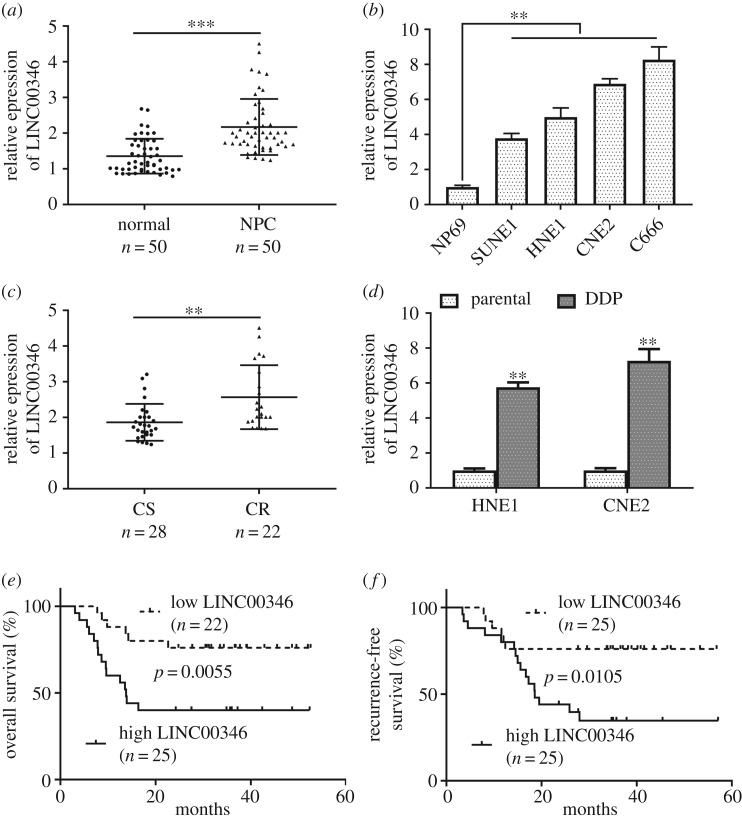
LINC00346 is upregulated in NPC and associated with cisplatin resistance and poor prognosis. (a) The relative expression of LINC00346 in 50 paired NPC specimens and adjacent normal tissues. (b) The relative expression of LINC00346 in four human NPC cell lines (SUNE1, HNE1, CNE2 and C666) and NP69, an immortalized nasopharyngeal epithelial cell line. (c) The relative expression of LINC00346 in NPC specimens from 28 CS patients and 22 CR patients. (d) Relative LINC00346 expression levels of parental NPC cells (HNE1 and CNE2) and cisplatin-resistant NPC cells (HNE1/DDP and CNE2/DDP). (e,f) Kaplan−Meier curves in NPC patients with high (n = 25) or low LINC00346 expression (n = 25) for (e) overall and (f) recurrence-free survival. **p < 0.01; ***p < 0.001.